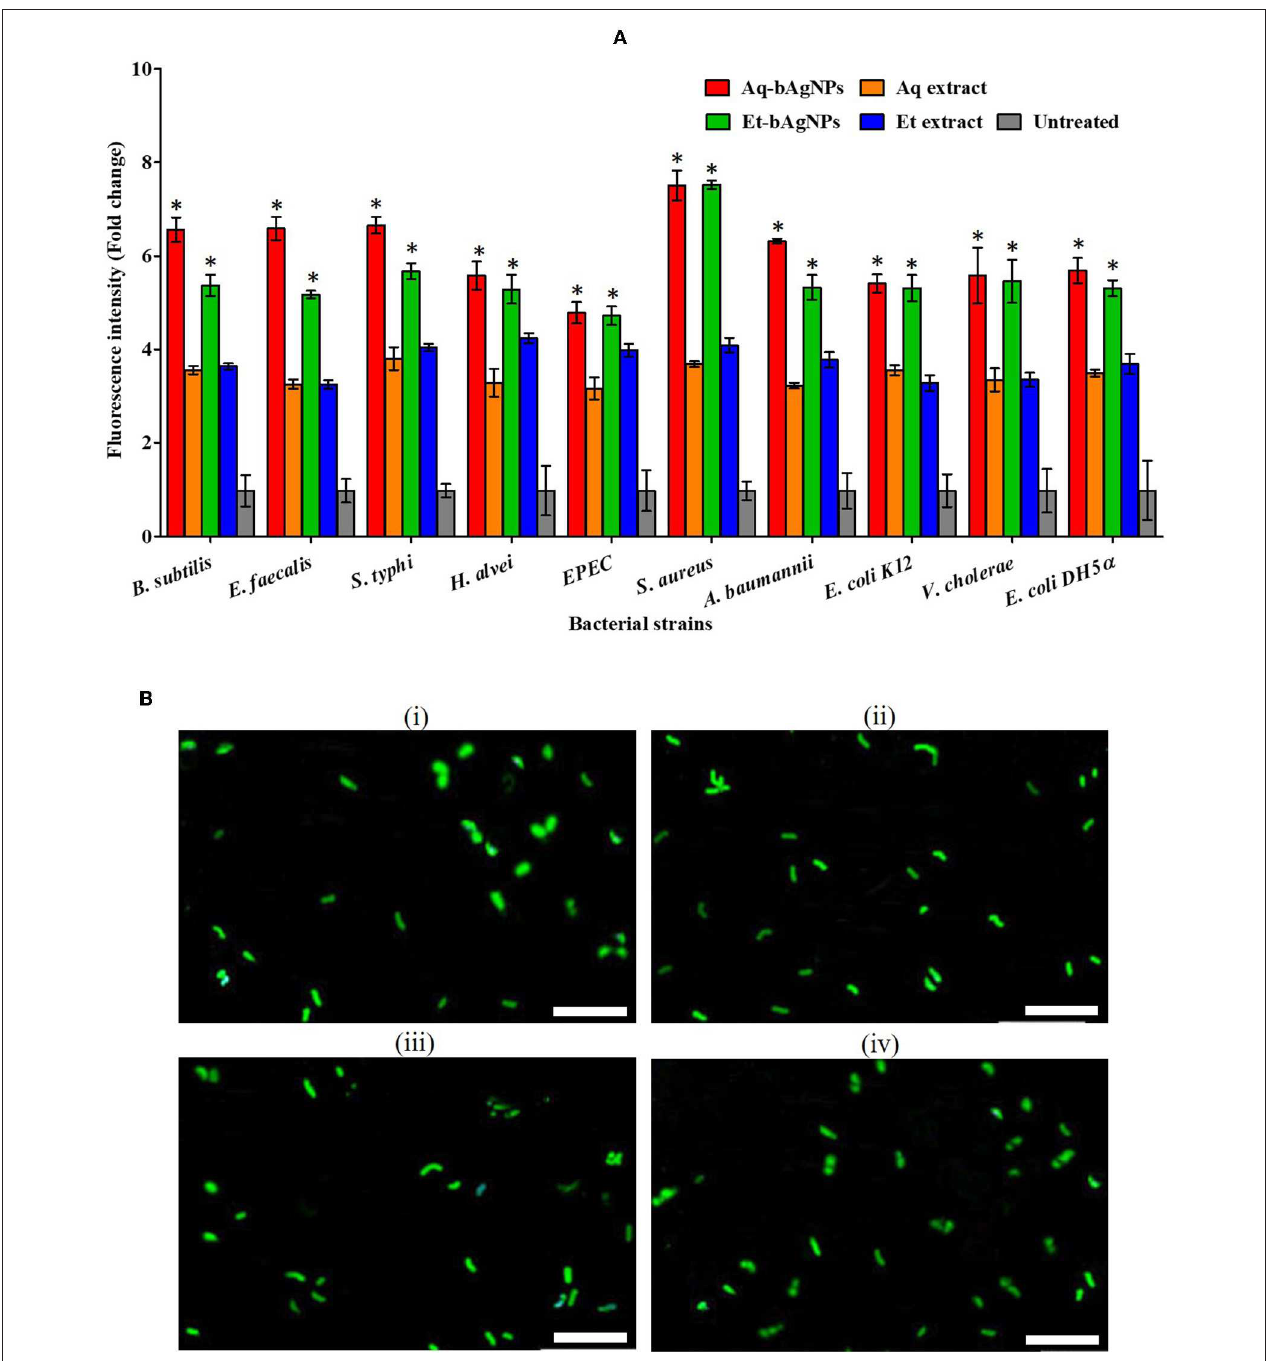
FIGURE 4 | (A) CellTox TM Green uptake assay. The fluorescence intensity of bacteria treated with Aq-bAgNPs and Et-bAgNPs was measured at 490nm using a spectrofluorometer. The values presented are mean ± SE of multiple samples ( n = 3). Data were analyzed using one-way ANOVA followed by Tukey’s multiple comparison test. The fluorescence intensity of both bAgNP-treated bacteria was significantly higher than that of the plant extract treated as well as untreated bacteria and * P < 0.05. (B) CellTox TM Green uptake assay. B. subtilis was first treated with Aq-bAgNPs (i) and Et-bAgNPs (ii). The treated bacteria were then incubated with CellTox TM green to stain the cell wall compromised bacterial DNA, and green fluorescence was observed under a fluorescence microscope. The same experiment was also performed for E. faecalis after treating them with Aq-bAgNPs (iii) and Et-bAgNPs (iv). Scale bar: 20 µ m.